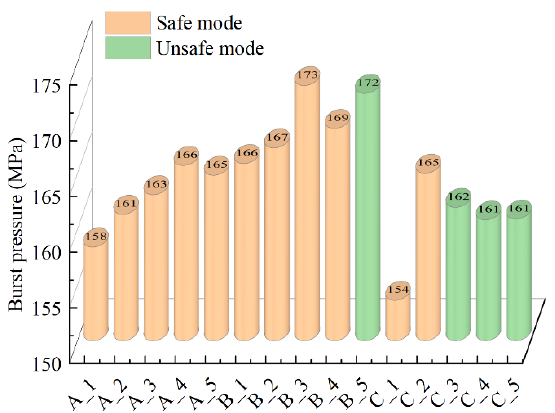
Figure 12. Numerical results of the burst pressure and the burst mode.